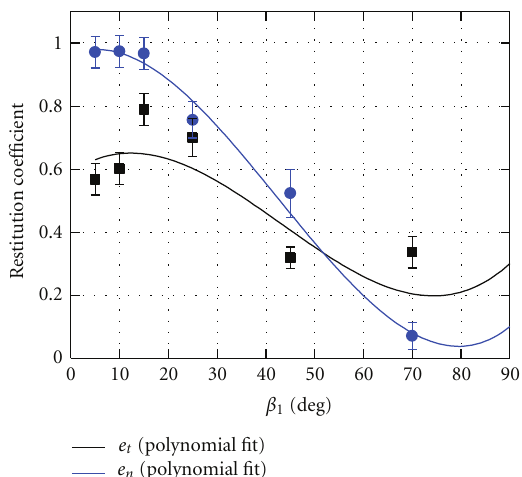
Figure 10: Tangential and normal restitution coe ffi cients variation with impact